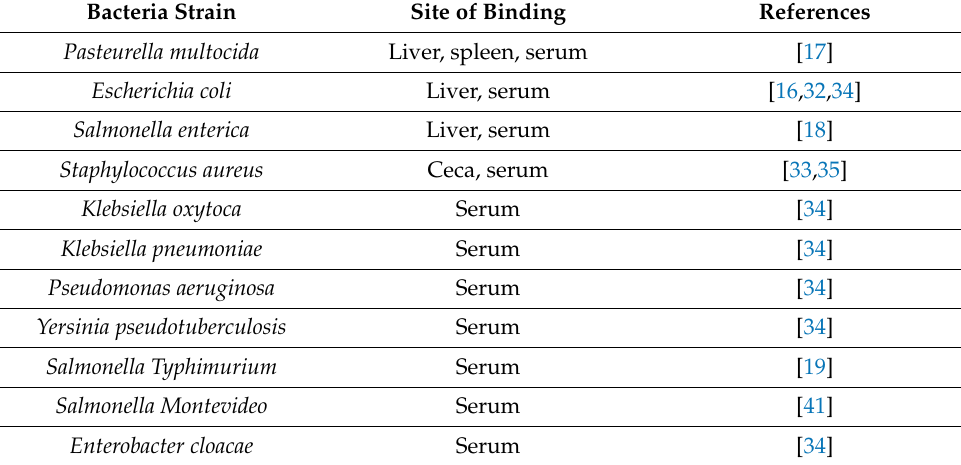
Table 3. Selected reports of cMBL (chicken mannose-binding lectin) bacterial